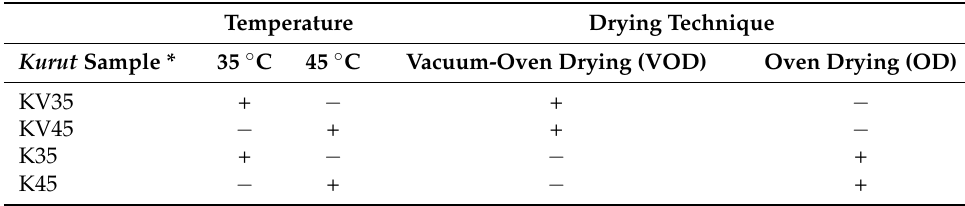
Table 2. Experimental design of the study. Temperature Drying Technique Kurut Sample *